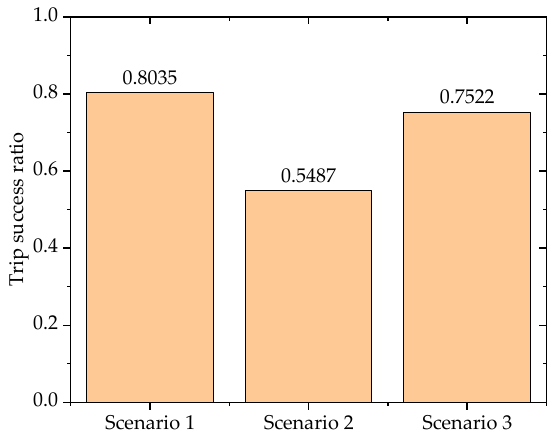
Figure 20. The travel success ratio under the three scenarios.